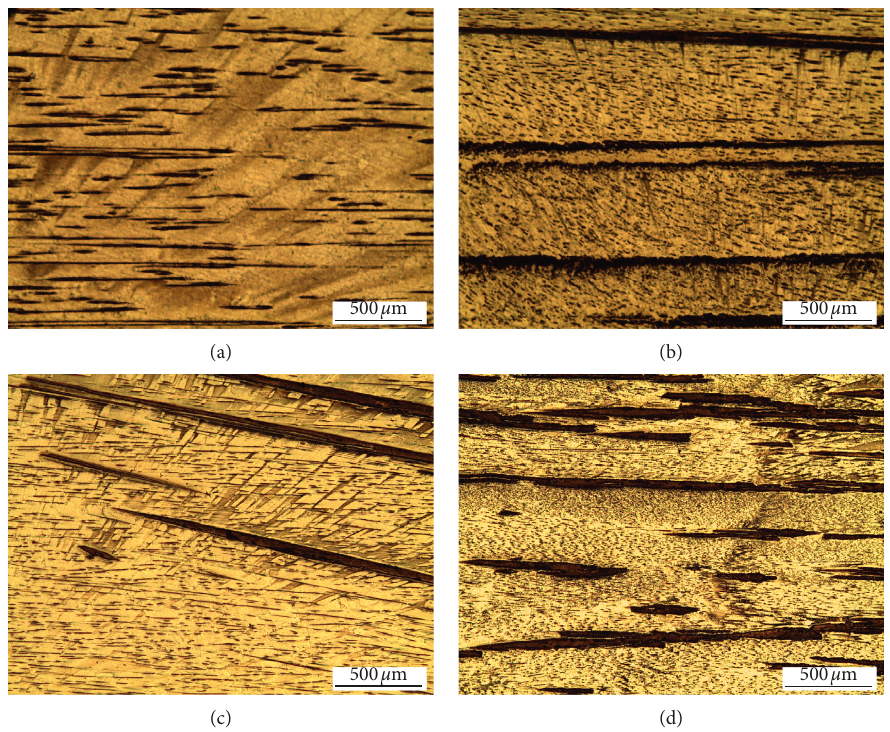
Figure 4: Detailed longitudinal views corresponding to the solidified zone (below solid+( η P + Liq) interface) for different pulling velocities: (a) V � 0.5 µ m/s; (b) V � 1.0 µ m/s; (c) V � 2.0 µ m/s; (d) V � 5.0 µ m/s. In all cases, G L �